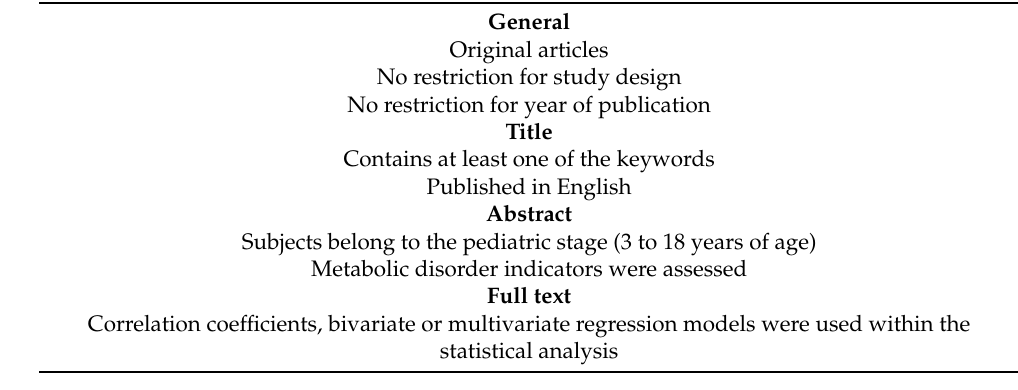
Table 1. Selection